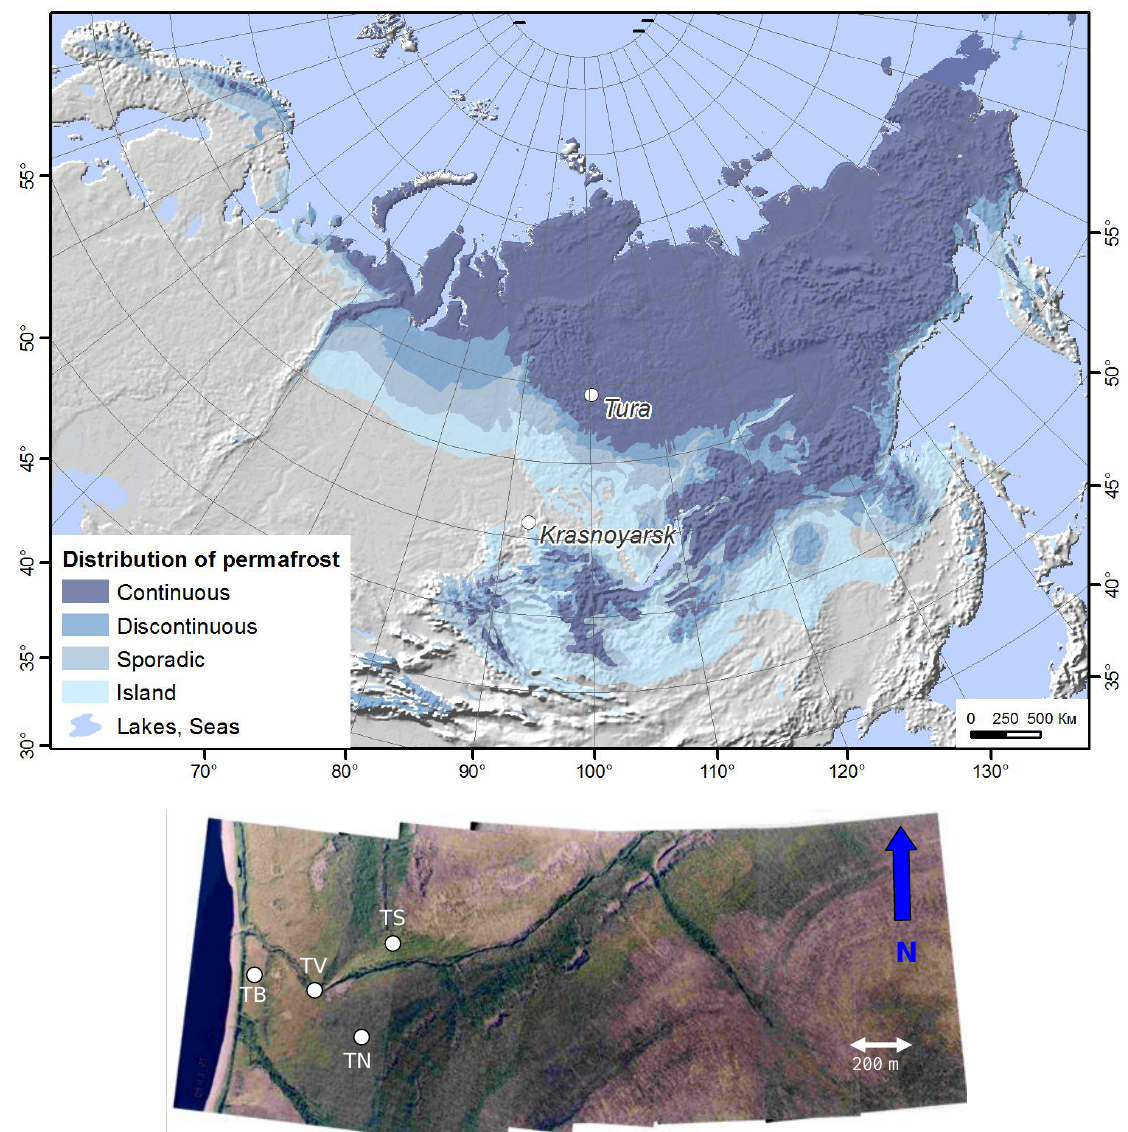
Figure 1. The map of permafrost distribution (adapted from Brown et al., 1998) and location of sites in Central Siberia. Bottom image shows the location of study sites in various habitats within permafrost terrain (Tura): TN—north-facing slope, TS—south-facing slope, TV—stream valley (riparian zone) and TB—bog.